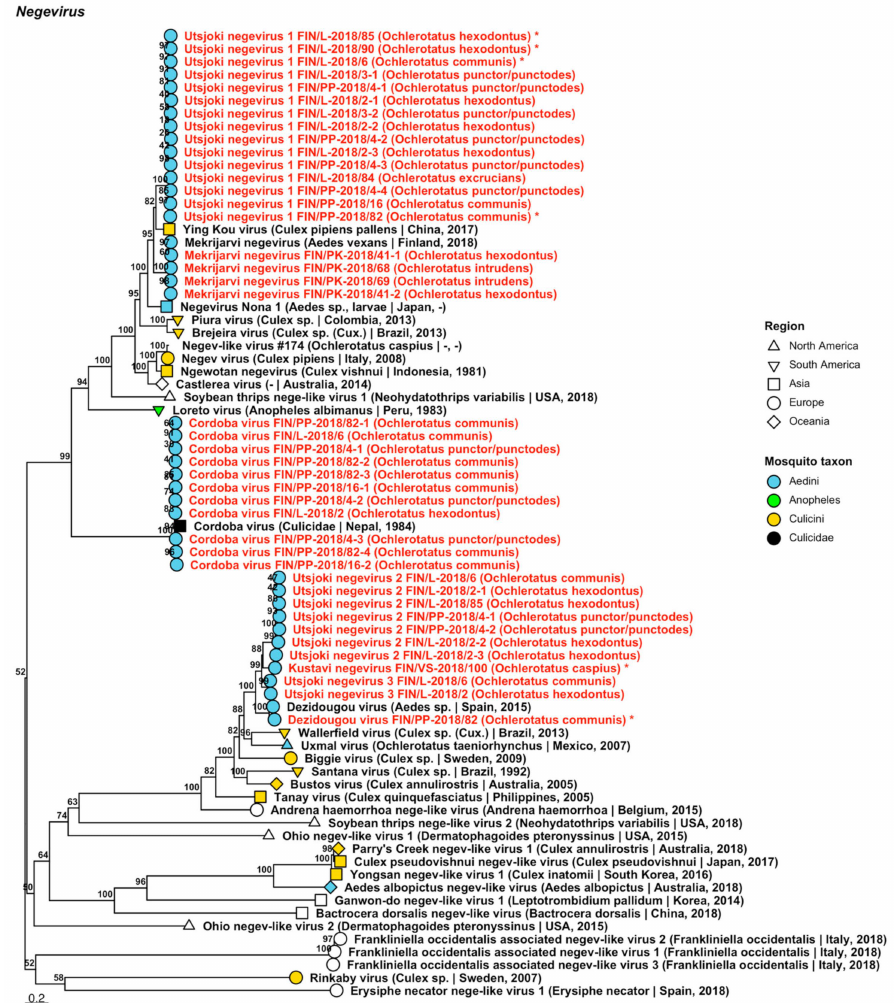
Figure 5. Maximum likelihood tree of Negevirus . Tentative novel viruses are displayed in red and the mosquito species from which they were derived are in parentheses. Sequences from GenBank are black and display the following information after the virus or species name: “(sampled organism(s) | collection country, collection year)”. Tip colours represent the tribe (Culicinae) or genus (Anophelinae) of mosquito from which viruses were obtained. Tip shape represents the continent or region from which the specimens were collected. Trees were constructed from amino acid sequences of virus polymerases >1000 nt, aligned with MAFFT and computed with IQ-TREE2 using ModelFinder and 1000 bootstraps. Asterisks denote that the complete genome was